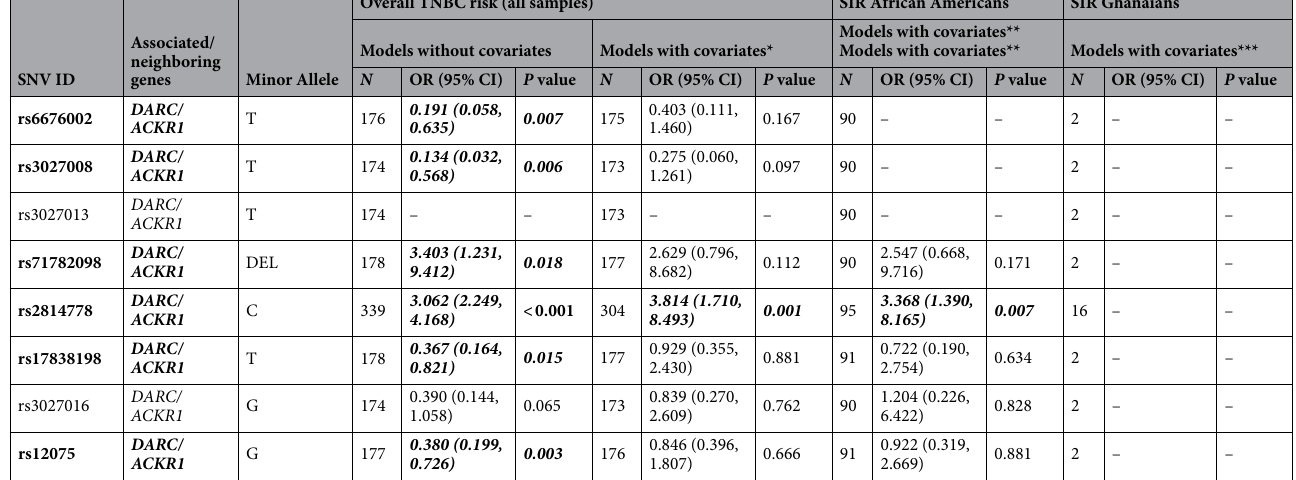
Table 5. TNBC-specific risk assessment (case-series) of DARC/ACKR1 alleles. Significant alleles ( p value < 0.05) are given in bold and italic *Overall analysis models with covariates adjusts for age and SIR. **SIR AA models with covariates adjusts for age and West African ancestry. ***SIR Ghanaian models with covariates adjusts for